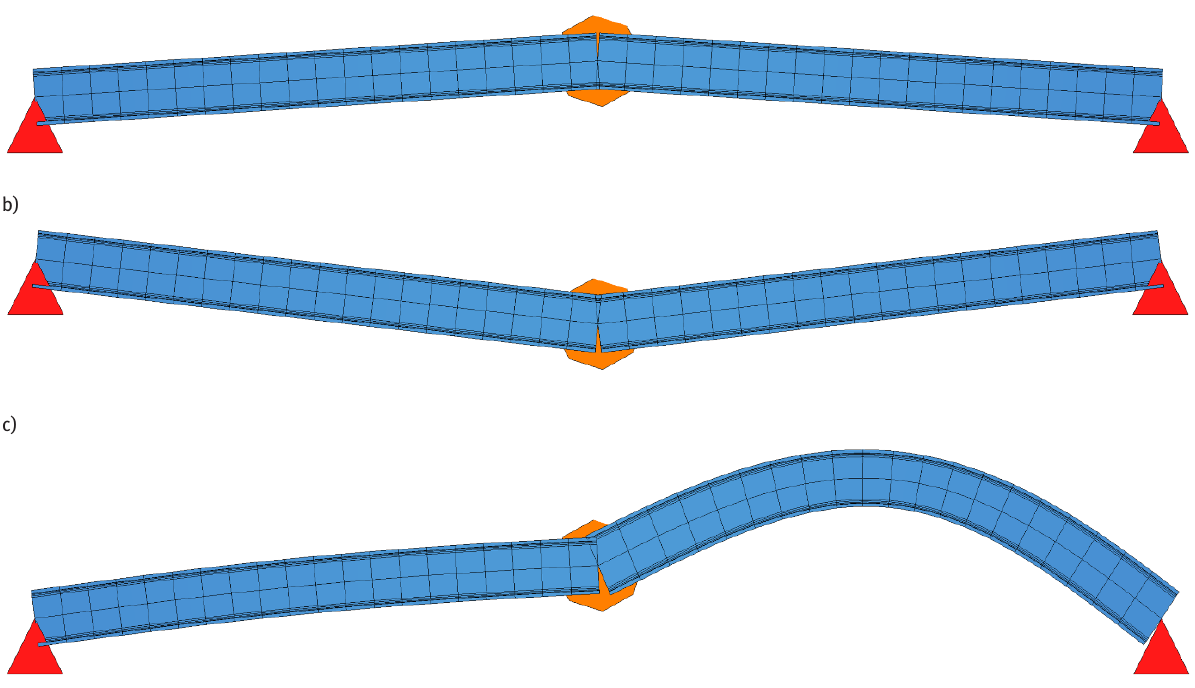
Figure 5: Instability forms: (a) structure without deformation, (b) form after snap-through, (c) first buckling